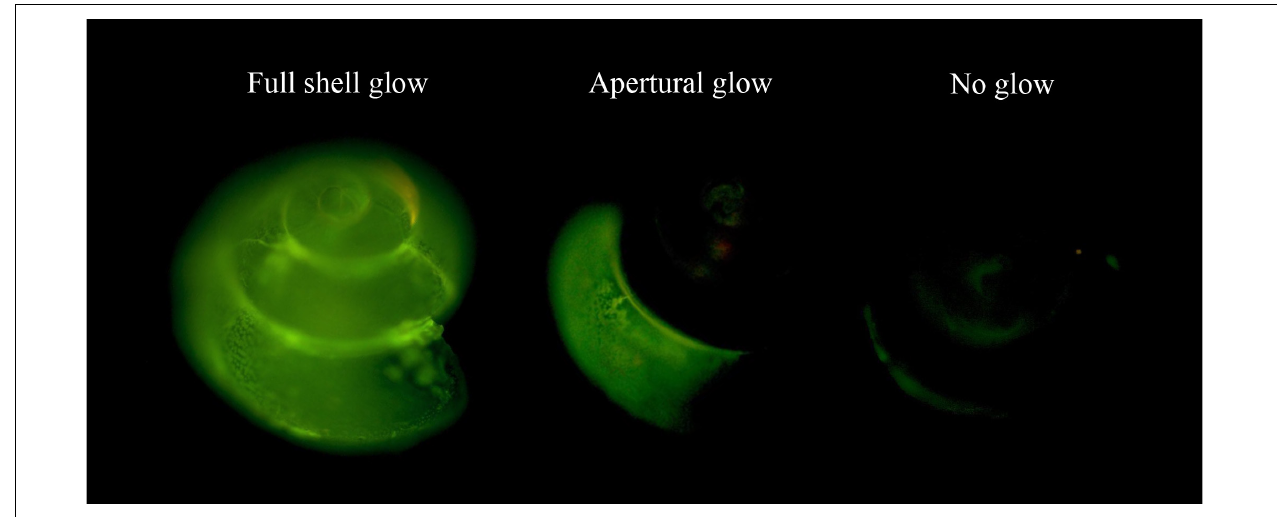
FIGURE 2 | Active calcification as detected by calcein incorporation using fluorescence microscopy. Calcein incorporation in Limacina retroversa showed three different patterns after a 3-day incubation: full glow, apertural glow, and no glow.